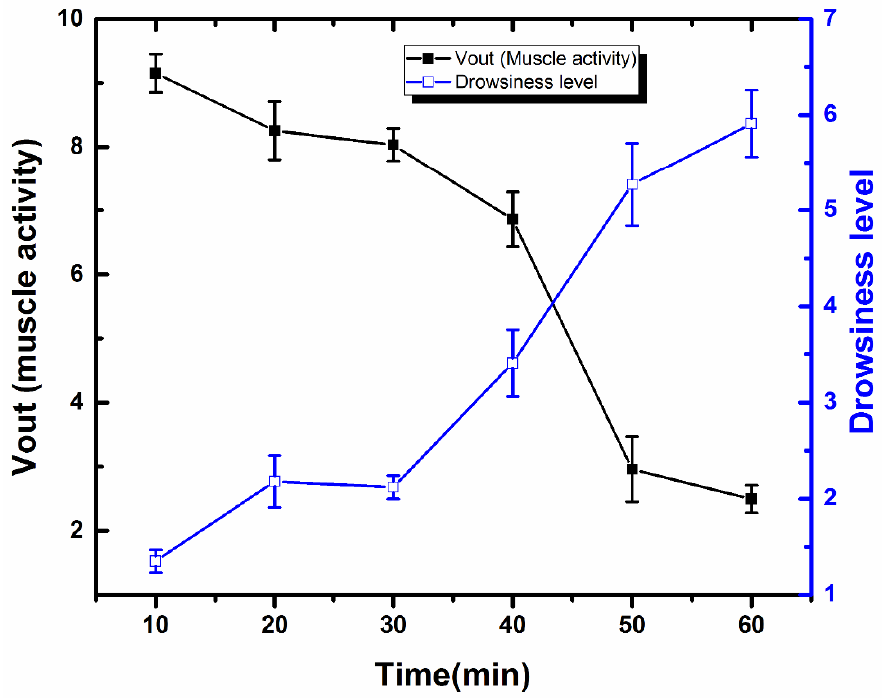
Figure 6. Degree of driver’s drowsiness and muscle activity over time. The data represents the average of three independent measurements with SE (n = 3).